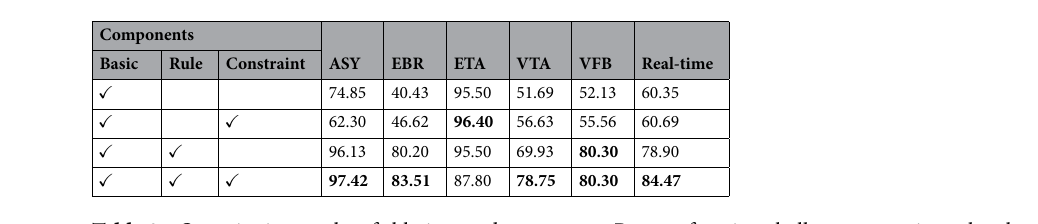
Table 3. Quantitative results of ablation study on test set. Best performing challenge scores in each column are given in bold.